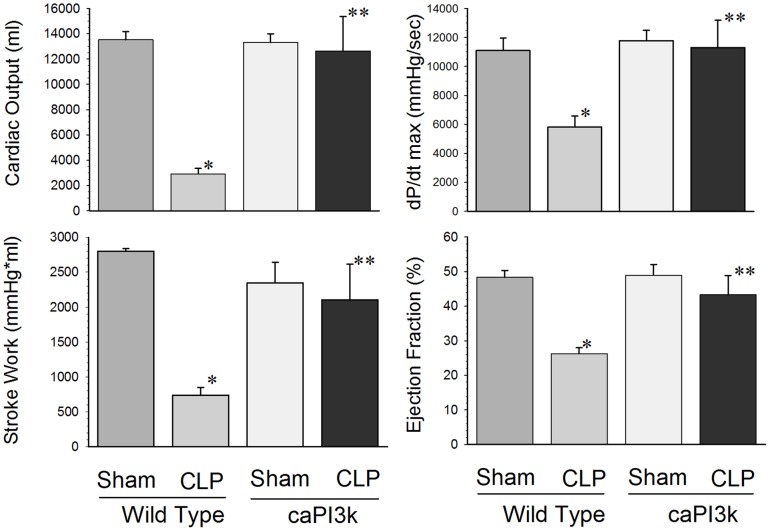
Cardiac myocyte specific expression of PI3K p110α attenuated cardiac dysfunction in CLP-induced septic mice.We performed hemodynamic and echocardiographic analysis at 6 hrs after CLP. Echocardiography confirmed that cardiac function was compromised in WT CLP. In contrast, caPI3K mice with CLP induced sepsis showed an overall maintenance of cardiac function. The bar graphs show the cumulative cardiac function data for the respective control and experimental groups. Six hrs after CLP, left ventricular hemodynamic parameters were examined. N = 5 mice/group. * p<0.05 compared to age-matched WT control. **p<0.05 compared to WT CLP group.